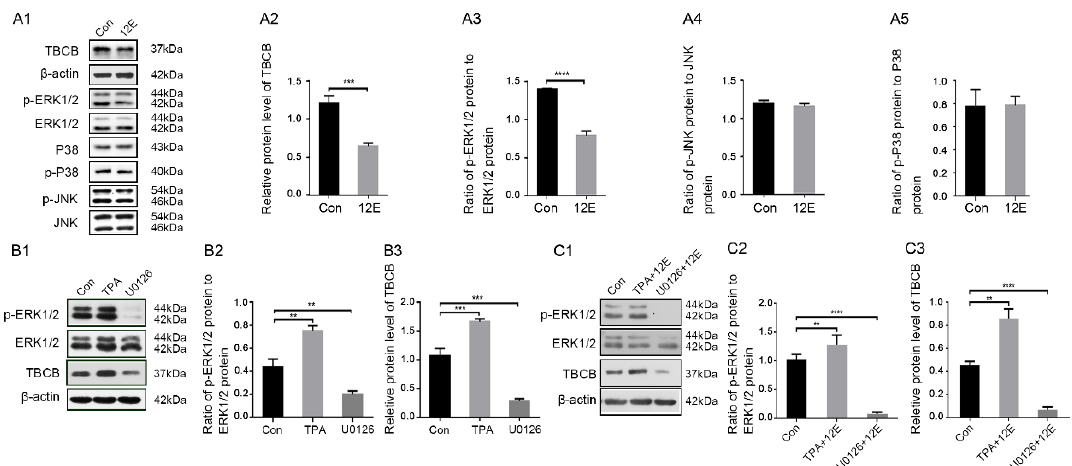
Figure 3. Changes in protein levels in the TBCB and ERK1/2 signalling pathways after alcohol exposure and the protein levels of TBCB and α -tubulin after interfering with the ERK1/2 signalling pathway. ( A ) Western blot analysis of phosphorylation levels and relative quantitative analysis of TBCB and MAPK (ERK1/2, p38, JNK) signalling pathways in astrocytes after 12 h of alcohol exposure ( n = 6, p < 0.05). ( B ) Western blot analysis of the p-ERK1/2 to ERK1/2 ratio and protein levels of TBCB and α -tubulin in astrocytes after pretreatment with the ERK1/2-specific inhibitor U0126 or agonist TPA ( n = 6, p < 0.05). ( C ) Western blot analysis of the p-ERK1/2/ERK1/2 ratio and protein levels of TBCB and α -tubulin in astrocytes after pretreatment with U0126 or TPA before alcohol exposure ( n = 6, p < 0.05). Con: control group; 12E: ethanol or alcohol exposure group; TAP: ERK1/2 agonist group; U0126: ERK1/2 inhibitor group; TPA + 12E: ERK1/2 agonist and ethanol exposure group; U0126 + 12E: ERK1/2 inhibitor and ethanol exposure group. **: p < 0.01; ***: p < 0.001, ****: p < 0.0001.